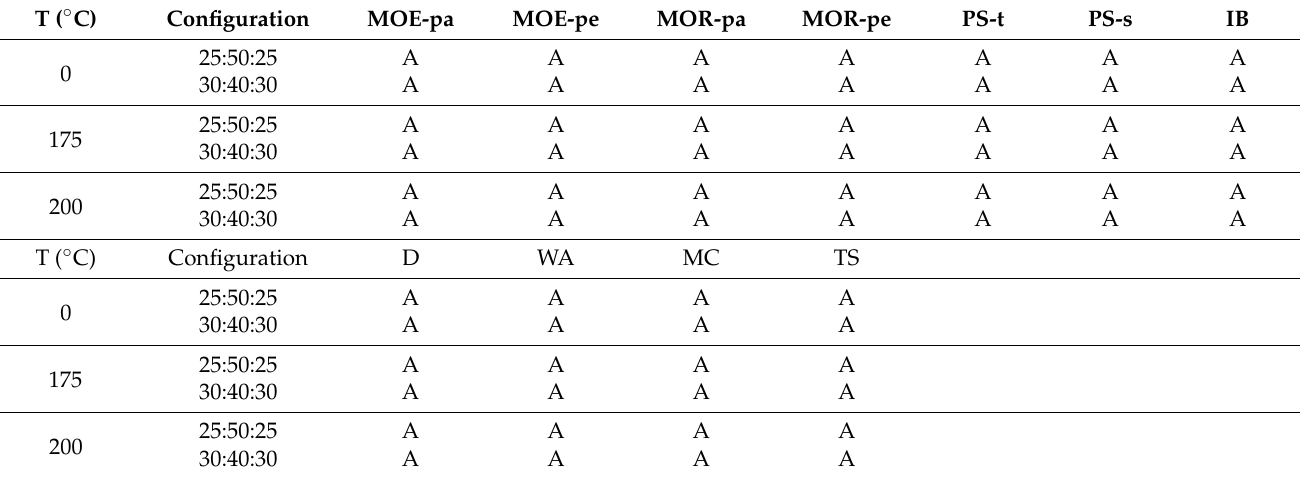
Table 4. Results of Tukey’s test on the influence of layer